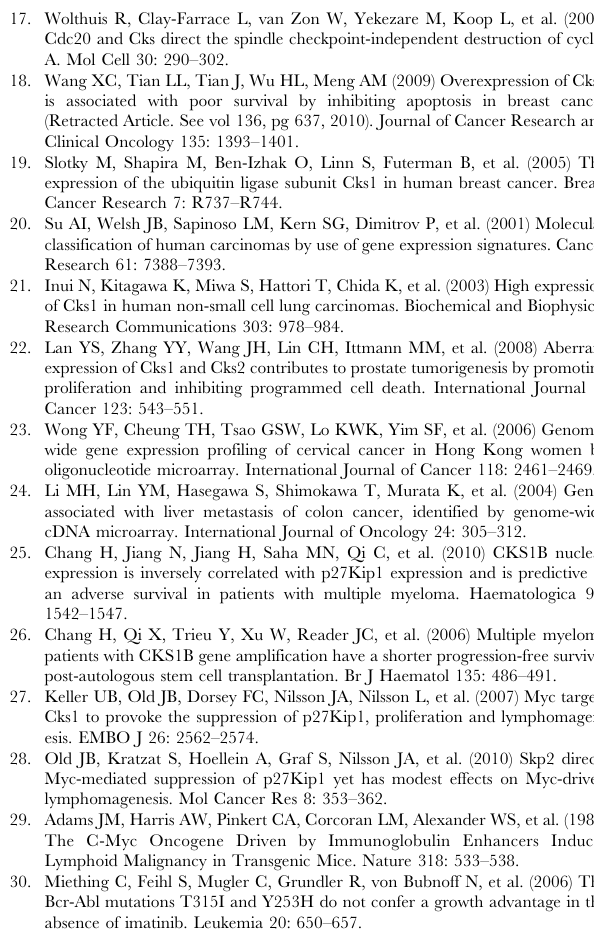
Figure S3 B cell-specific overexpression of Cks1 does not lead to a change in B cell frequency, cell cycle state, or differentiation. Experiments were performed 28 days after bone marrow transplantation of 2 6 10 6 GFP-positive cells and an infection efficiency of about 40%. Left panel: Flow cytometric detection of the percentage of Cks1 overexpressing B cells versus controls in the lymphoid compartment of the bone marrow using GFP as a marker. Middle panel: Flow cytometric anti-BrdU staining of GFP-positive B220 + B cells. 1 mg BrdU/g body weight was intraperitoneally injected 12 hours before bone marrow harvest. The bars represent the mean 6 standard deviation of n =7 or n =6 individual mice per group. Right panel: Flow cytometric measurement of the differentiation pattern of Cks1 overexpressing B cells versus controls (GFP + , B220 +